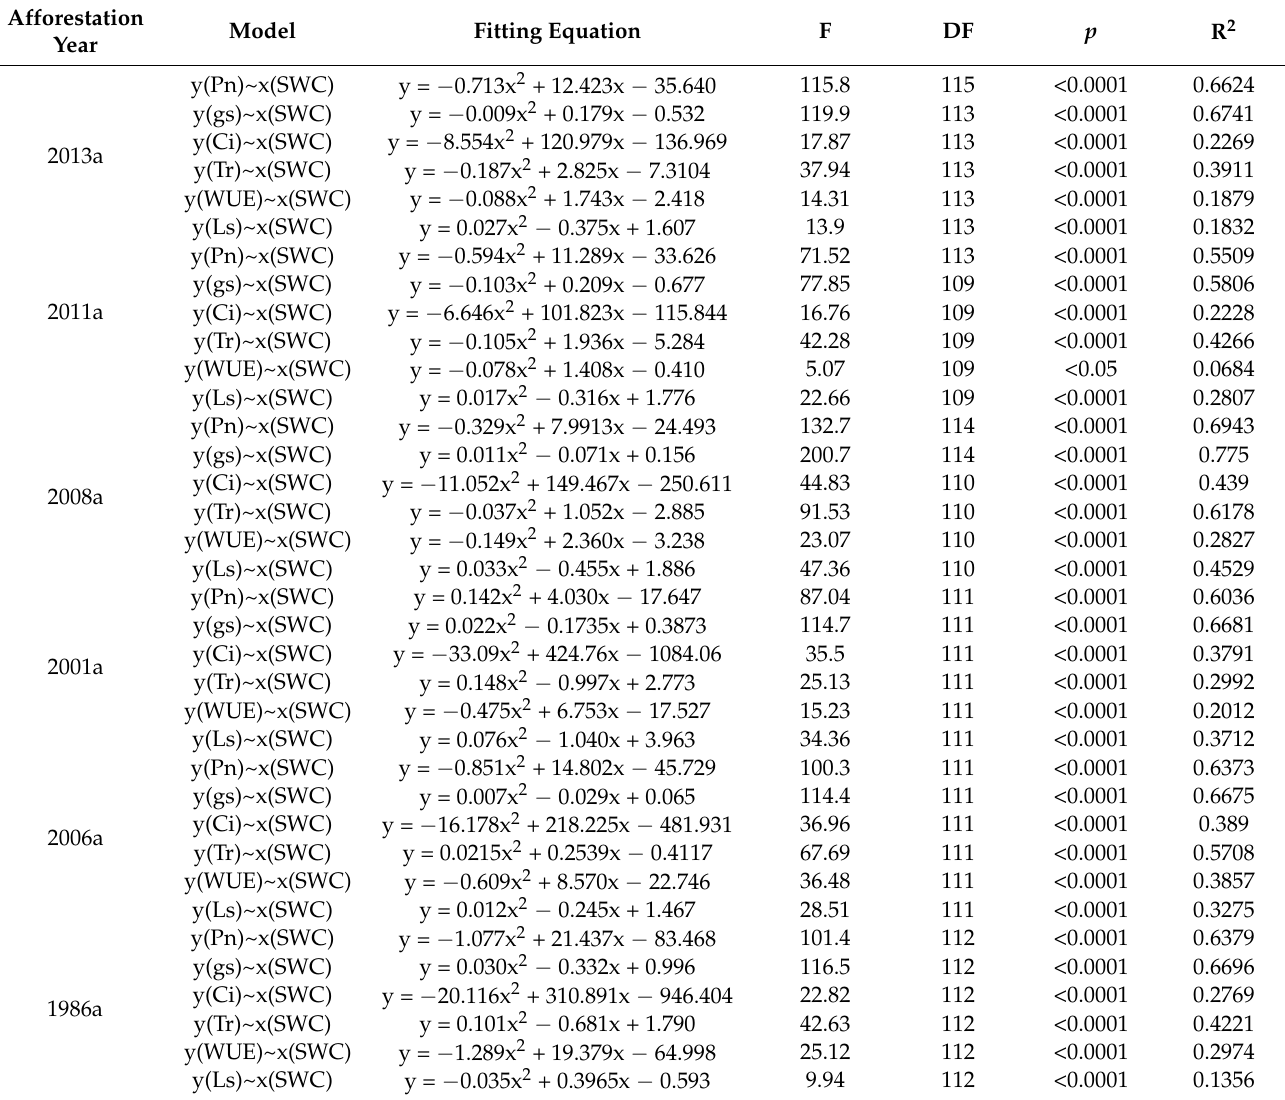
Table 5. Regression equation between photosynthetic parameters and